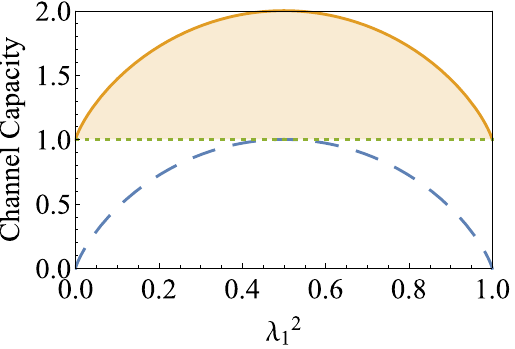
Figure 1. Channel capacities with and without Charlie’s assistance and MCP for generalized GHZ states. The solid curve represents channel capacities with Charlie’s assistance, the dotted line those without Charlie’s assistance, and dashed curve MCP of generalized GHZ states. The shaded region represents the amount of channel capacity controlled by